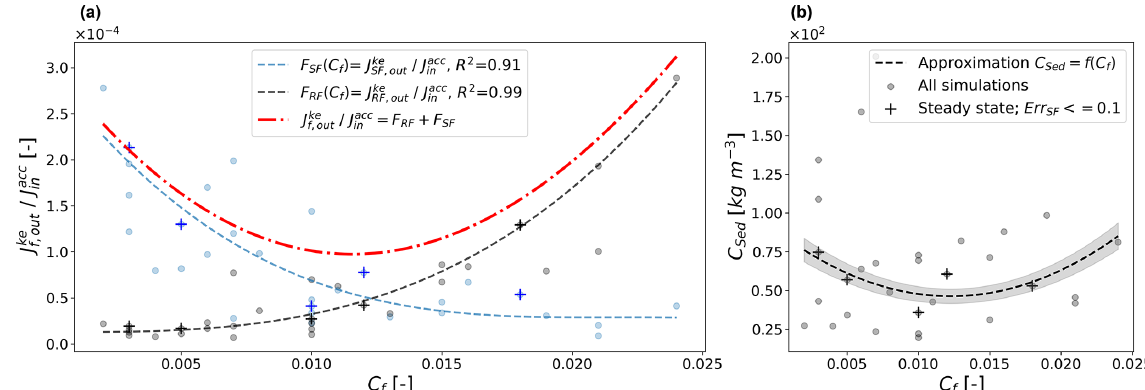
Figure 10. (a) Relative flux of kinetic energy at the hillslope outlet as a function of flow accumulation for rill domain ( F RF ) and sheet domain ( F SF ) as well as total relative flux ( F RF + F SF ). (b) Measured sediment concentrations at hillslope outlet plotted against the flow accumulation (cid:12) (cid:12) parameter C f ; simulations with Err SF = (cid:12) /v SF , obs below 10% and classified steady state are marked with “ + ”. (cid:12) v SF , sim − v SF , obs